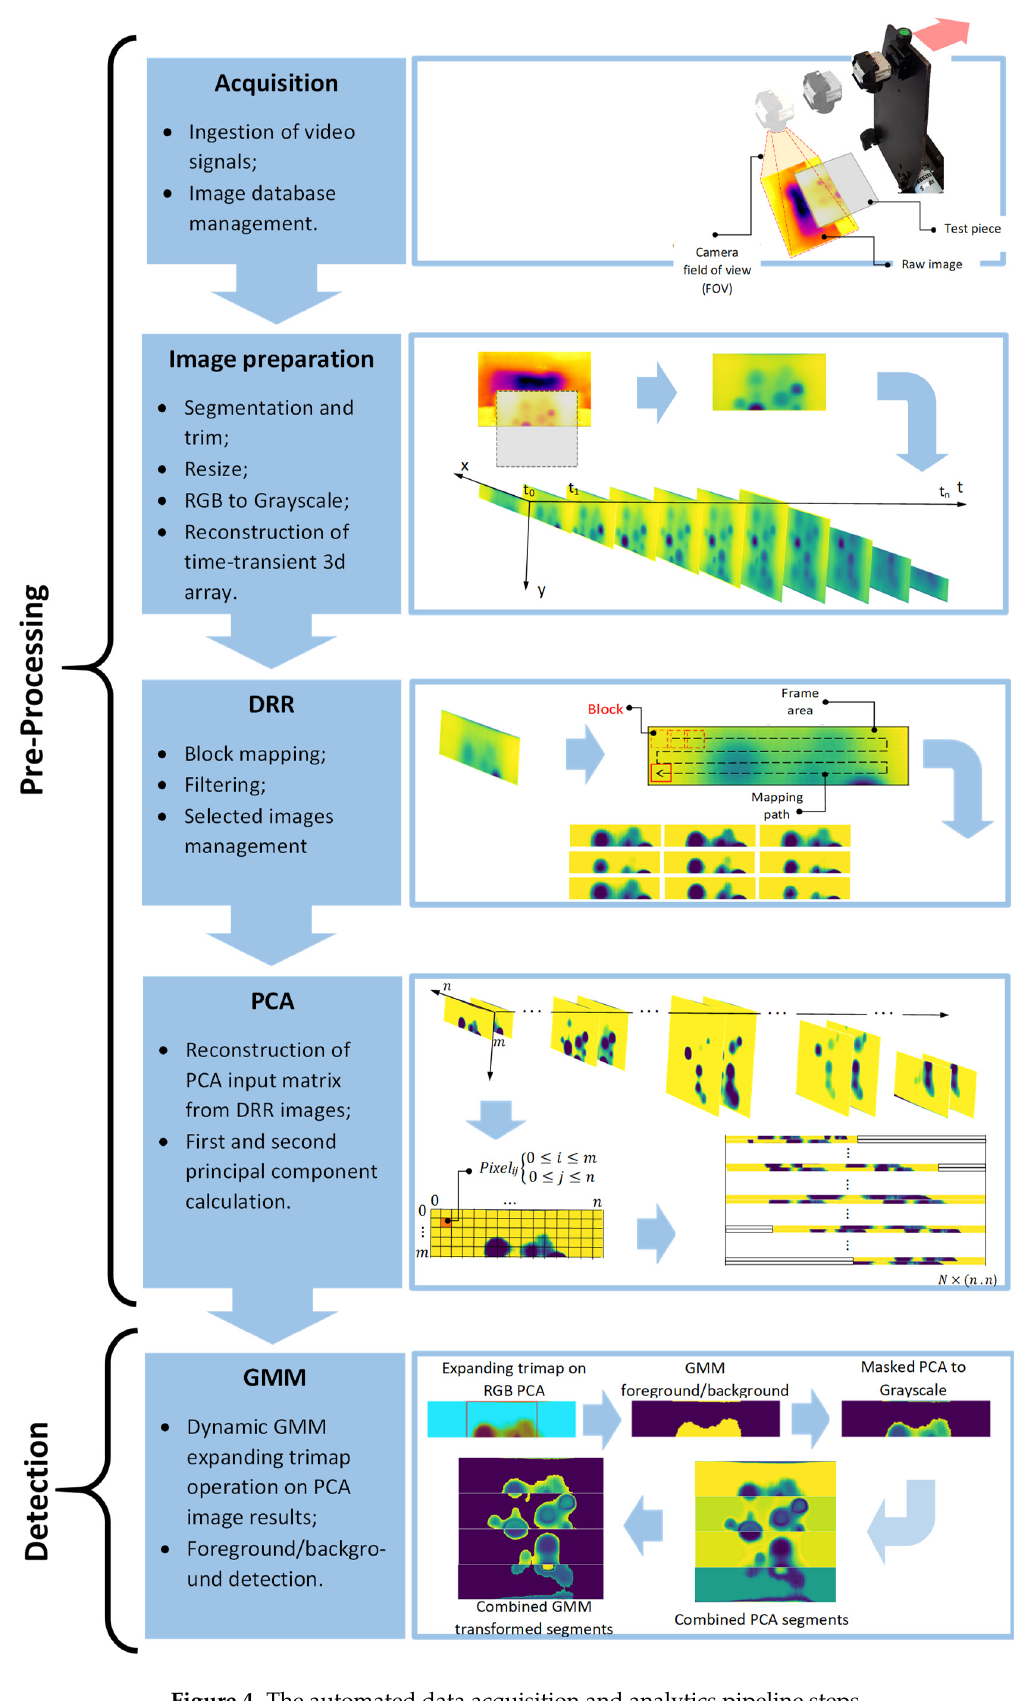
Figure 4. The automated data acquisition and analytics pipeline steps.